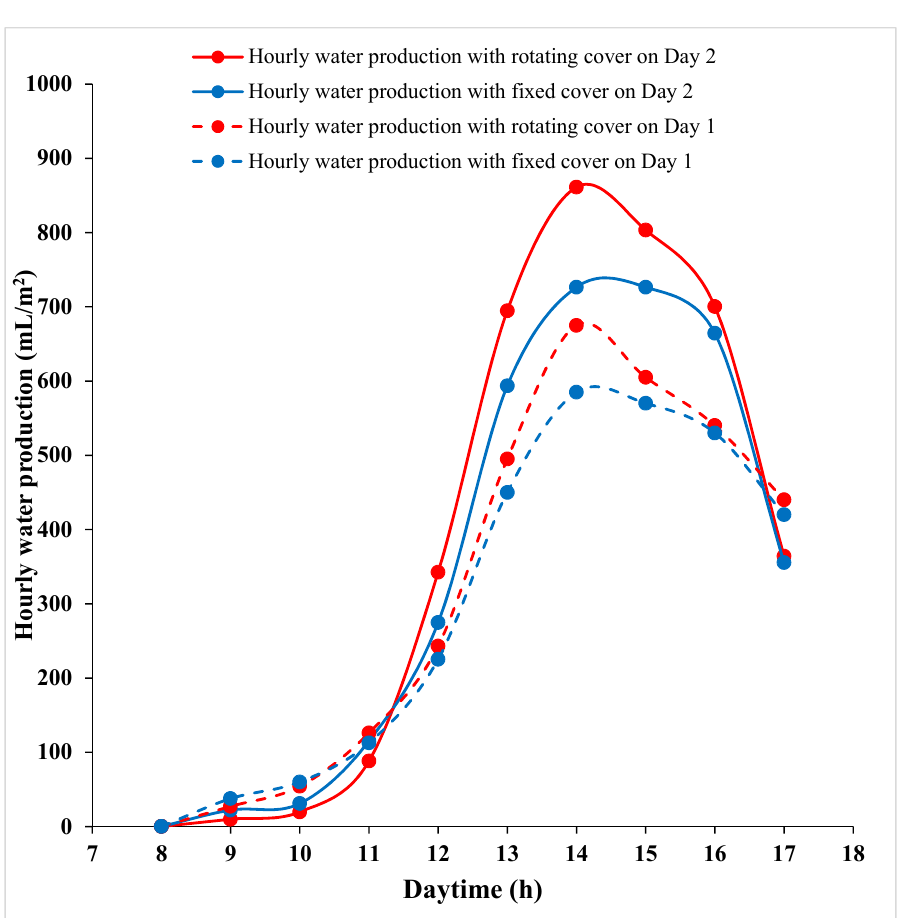
Figure 7. Hourly water production for 27 August (day 1) and 28 August (day 2) 2021, where the cylindrical cover is fixed or rotates.